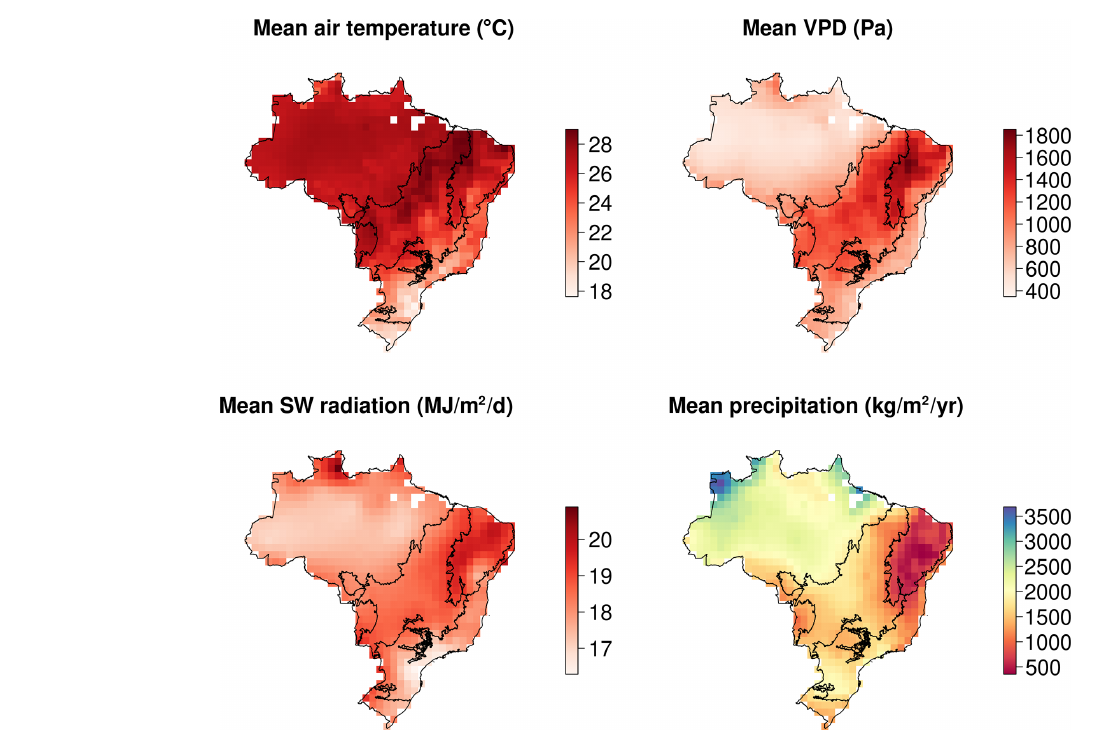
Figure A2. Mean meteorological conditions for the calibration period from CRU-JRA dataset (2001–2017).